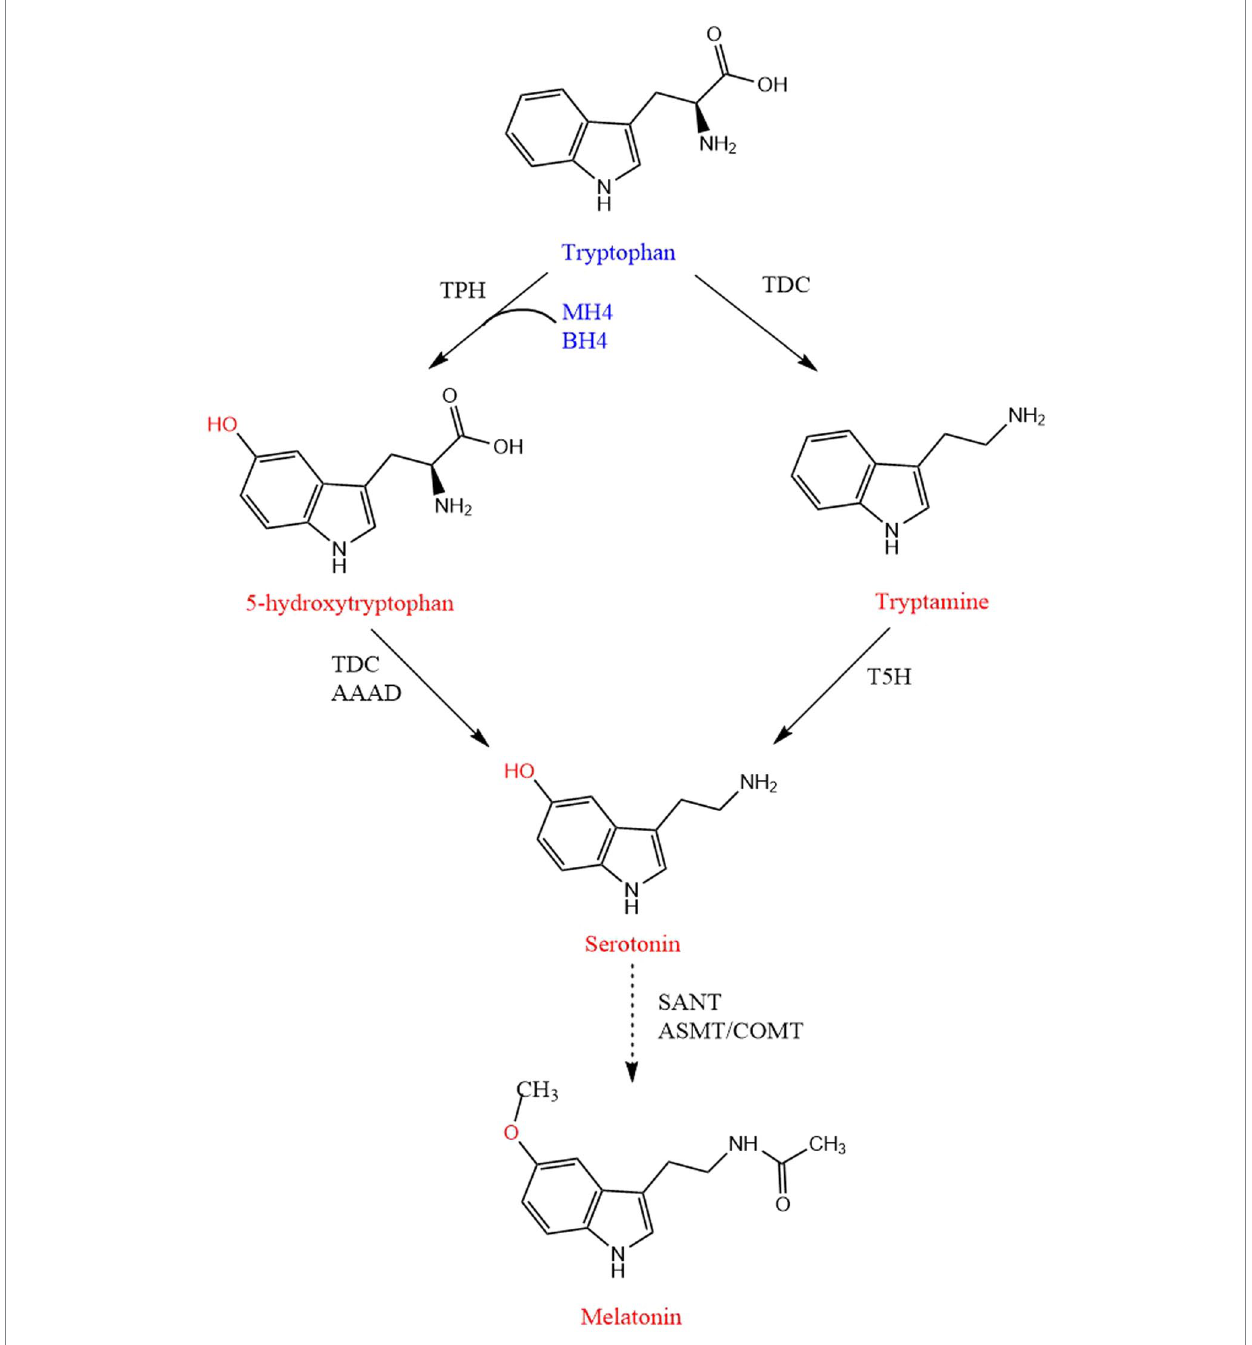
FIGURE 3 Biosynthetic pathway of 5-HTP, serotonin, and melatonin. Linear and dashed lines mean a single-step and multi-steps, respectively. TPH, Tryptophan 5-hydroxylase; TDC, Tryptophan decarboxylase; AAAD, Aromatic amino acid decarboxylase; T5H, Tryptamine 5-hydroxylase; SNAT, Serotonin N-acetyltransferase; ASMT, N-acetylserotonin O-methyltransferase; COMT, Caffeic acid O-methyltransferase; BH4, Tetrahydrobiopterin; MH4,